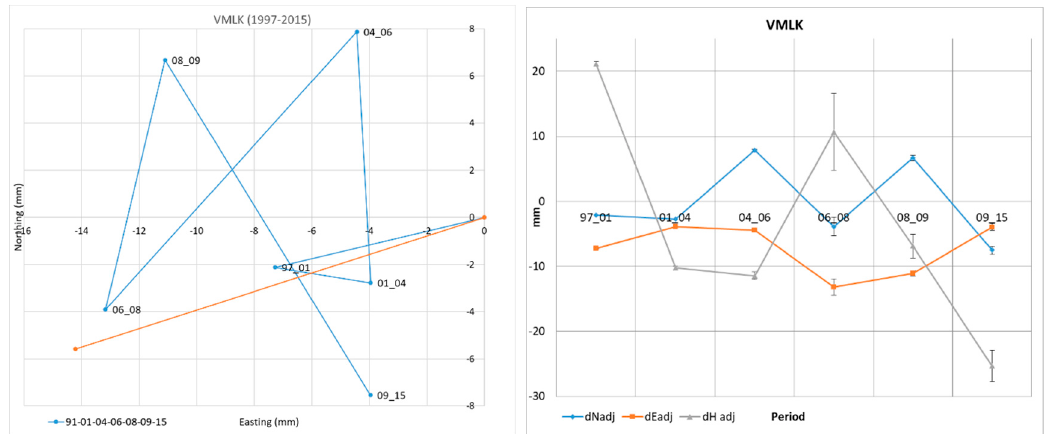
Figure 9. A typical example of movement direction change. Most active period 2006–2008 and 2009–2015. Movement causes—position in the framework.